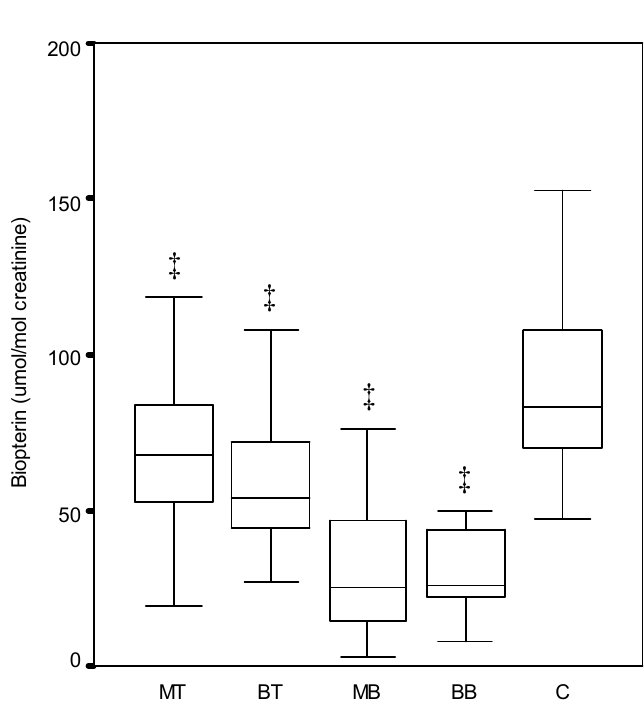
Figure 2. Box plots of urinary biopterin concentrations of the patients groups (shown are medians = horizontal lines, interquartile ranges = boxes, and ranges = bars). MT, malign thyroid (n = 17); BT, benign thyroid (n = 42); MB, malign breast (n = 24); BB, benign breast diseases (n = 19), and C, control group (n = 30). ‡p < 0.05 vs. con- trol group